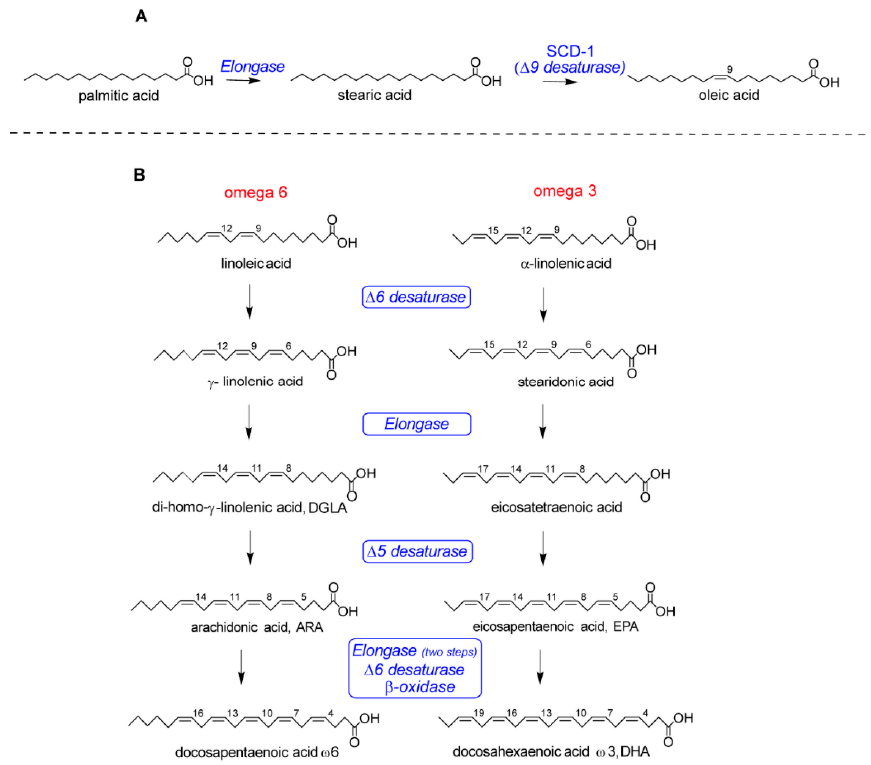
Figure 2. Some metabolic transformations of fatty acids: ( A ) the saturated fatty acid (SFA), palmitic acid, is transformed into stearic acid and the monounsaturated fatty acid (MUFA), oleic acid; ( B ) omega-6 and omega-3 precursors taken from the diet are transformed into the other polyunsaturated fatty acids (PUFA) members of the two families.